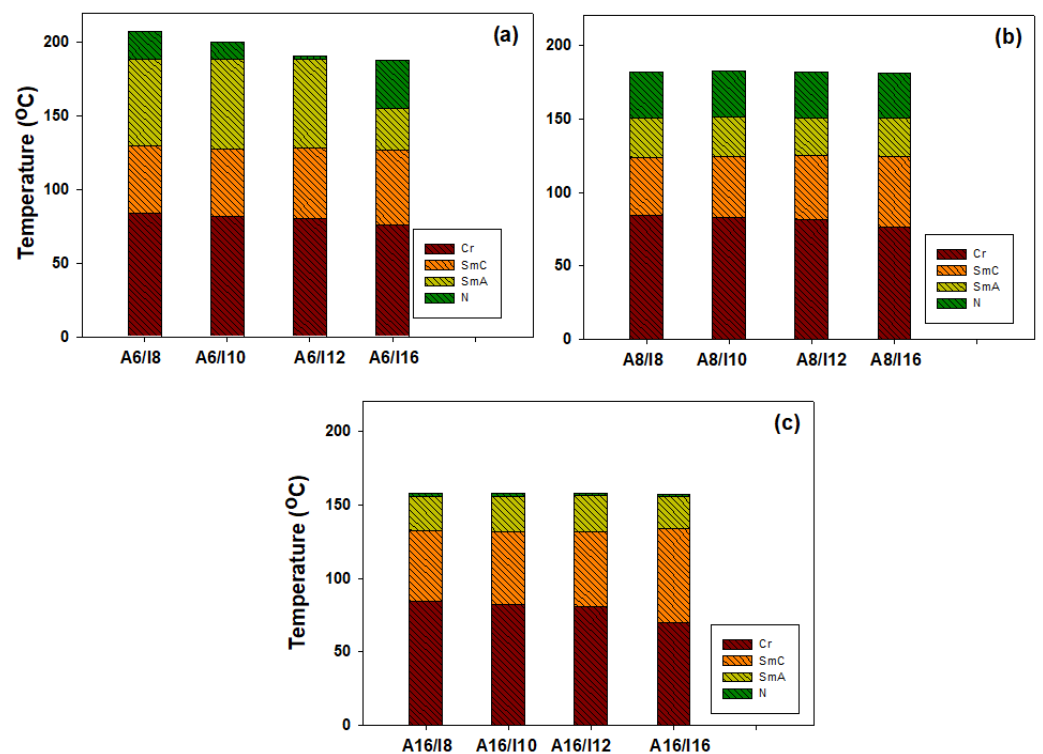
Figure 2. Effect of the alkoxy-chain length ( m ) of the azopyridine-based derivative ( Im ) on mesophase behavior of the 1:1 SMHBCs ( a ) A6 / Im ; ( b ) A8 / Im ; ( c ) A8 / Im .